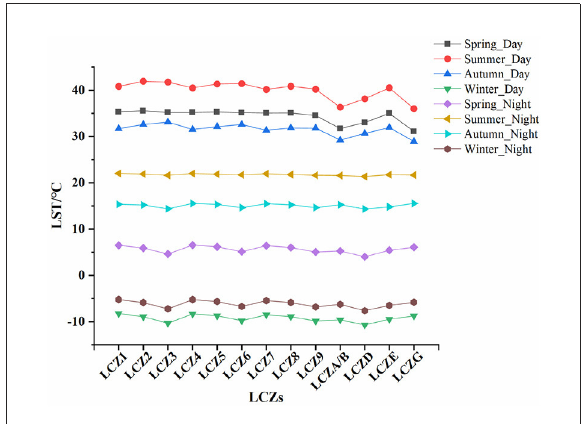
FIGURE5 Temperature variation of each day and night LCZ during the different